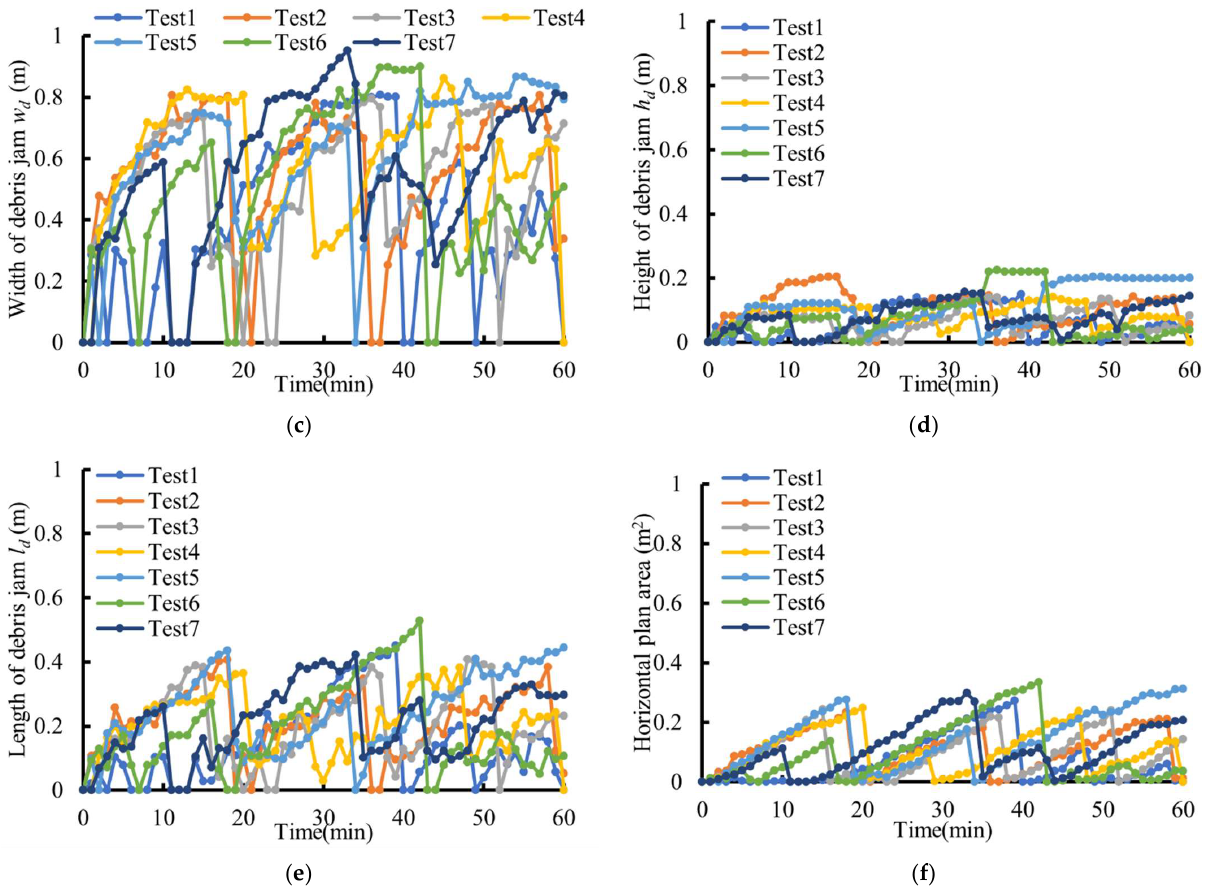
Figure 6. Temporal evolution of woody debris pieces in front of the pier as well as the corresponding plane area of the woody debris jam ( a ) test 2; ( b ) test 4, and ( c – f ) referred to the temporal evolution of width, height, length, and horizontal plan area of dynamic debris jam.